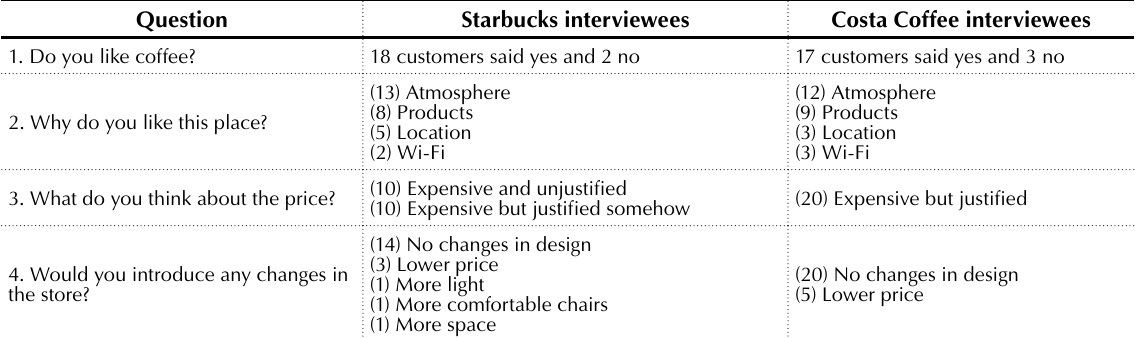
Table 2. General questions